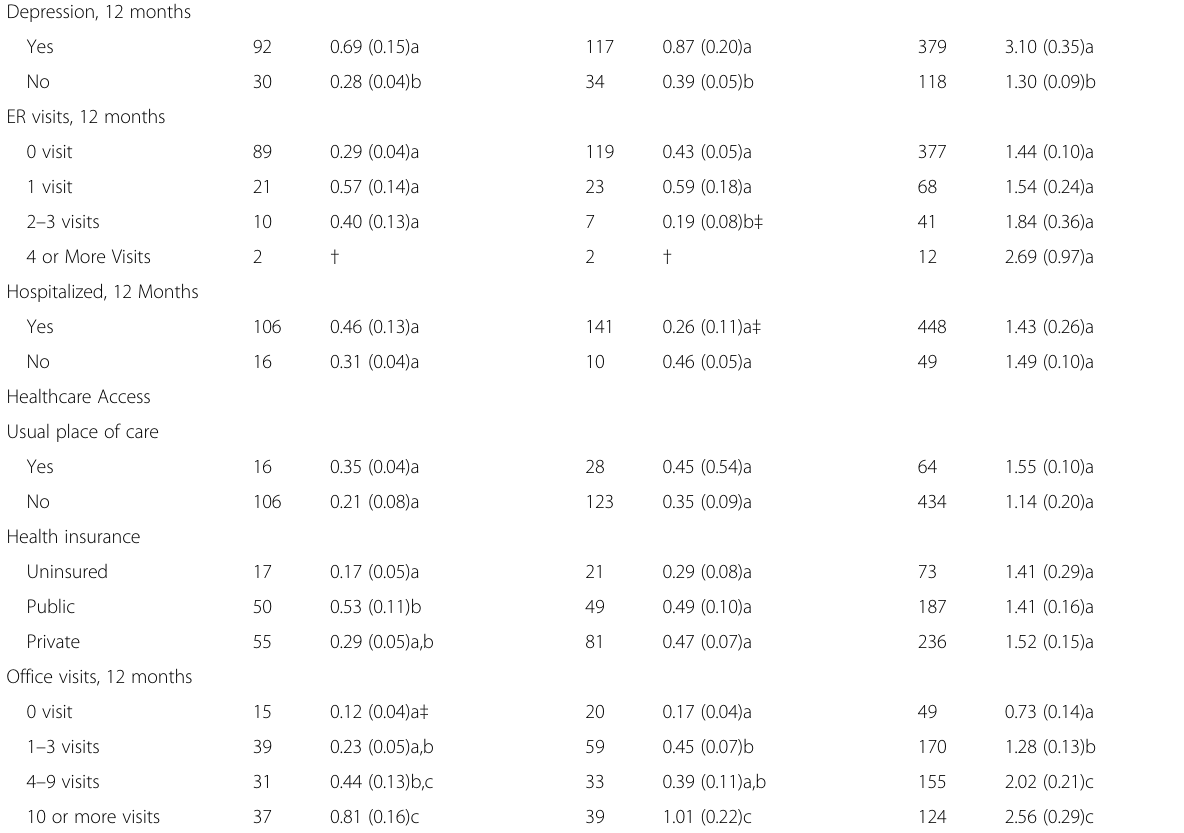
Table 2 Prevalence of meditation use by select user characteristics, exclusive use of one practice during previous 12 months 1